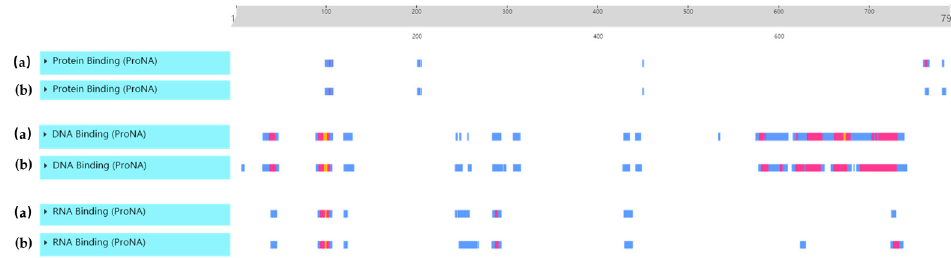
Figure 5. ARNT secondary structures of (a) Hu and (b) Texel sheep. The blue box refers to low binding sites (RI:0–33); the red box refers to intermediate binding sites (RI:34–66); and the yellow box refers to high binding sites (RI:66–100).